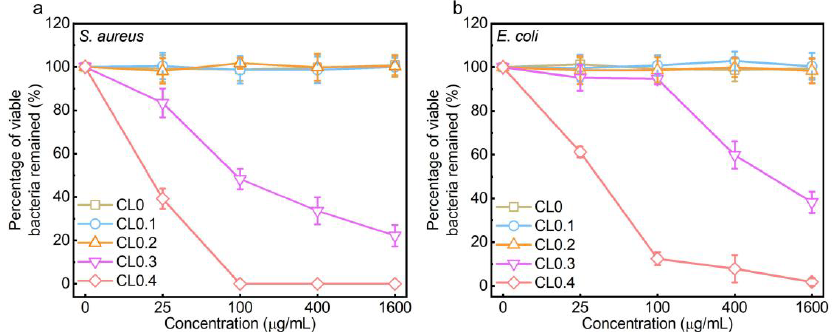
Figure 2. Antibacterial activities of CLs. Line charts showing viable bacterial percentages of S . aureus ( a ) and E . coli ( b ) after being treated with CL0, CL0.1, CL0.2, CL0.3, or CL0.4 at various concentrations for 5 h.